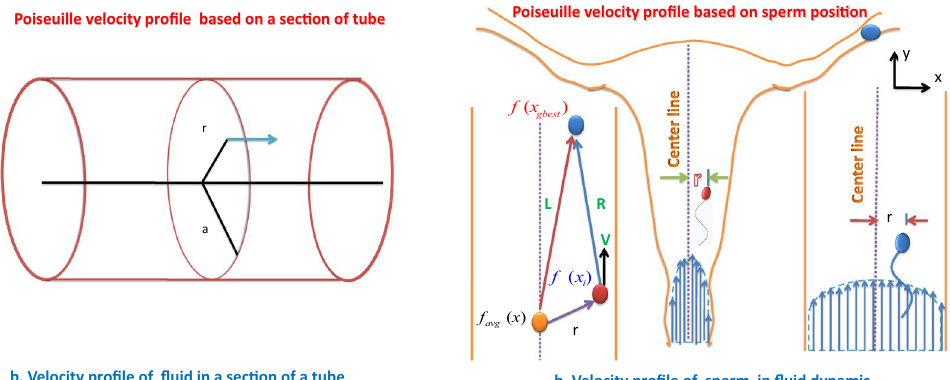
Figure 2. Sperm velocity profile: ( a ) a section of tube of radius (a), Velocity of fluid at a distance r from the center of the tube. ( b ) Sperm velocity profile based